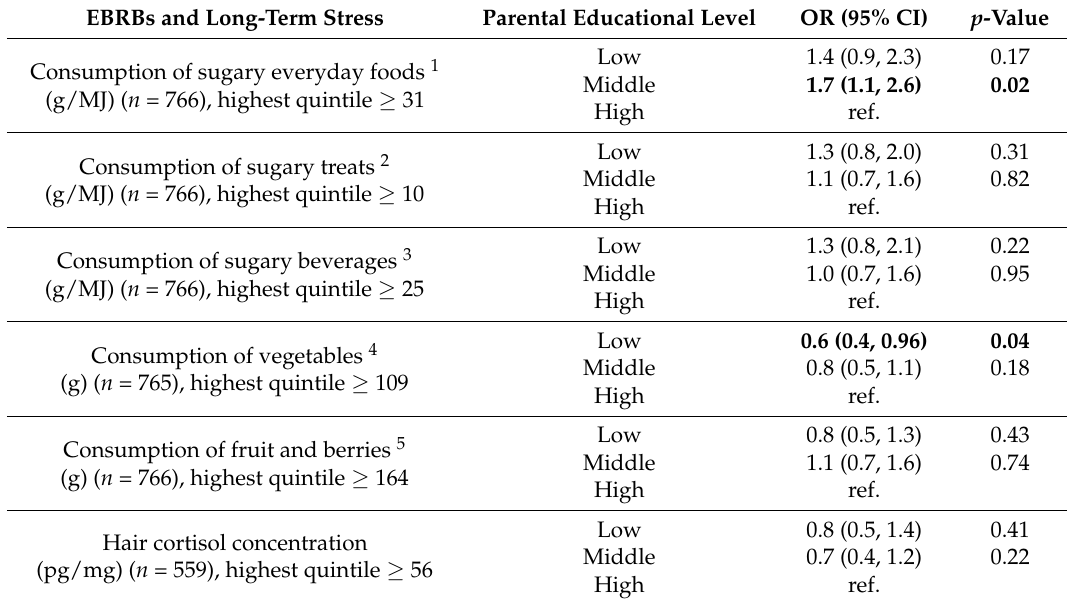
Table 3. Odds ratios (OR) and 95% confidence intervals (CI) for being in the highest quintile of consuming sugary everyday foods, sugary treats, sugary beverages, vegetables, and fruit and berries (3-day food record) or levels of long-term stress according to parental educational level (low/middle/high) from logistic regression